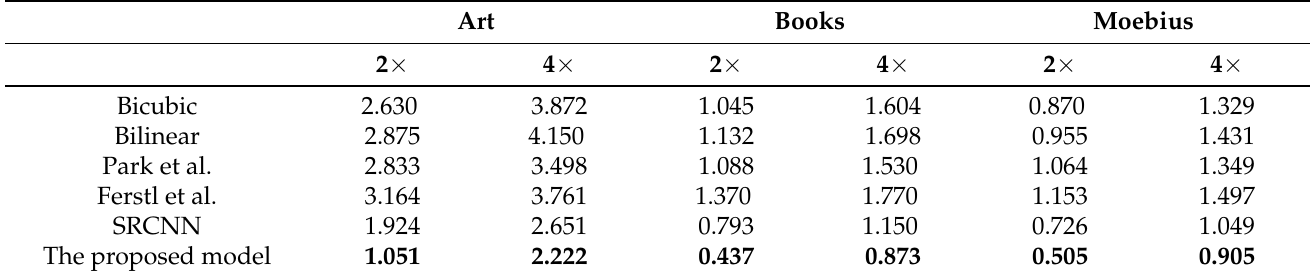
Table 1. Comparison of RMSE results of several methods (Art/Books/Moebius).